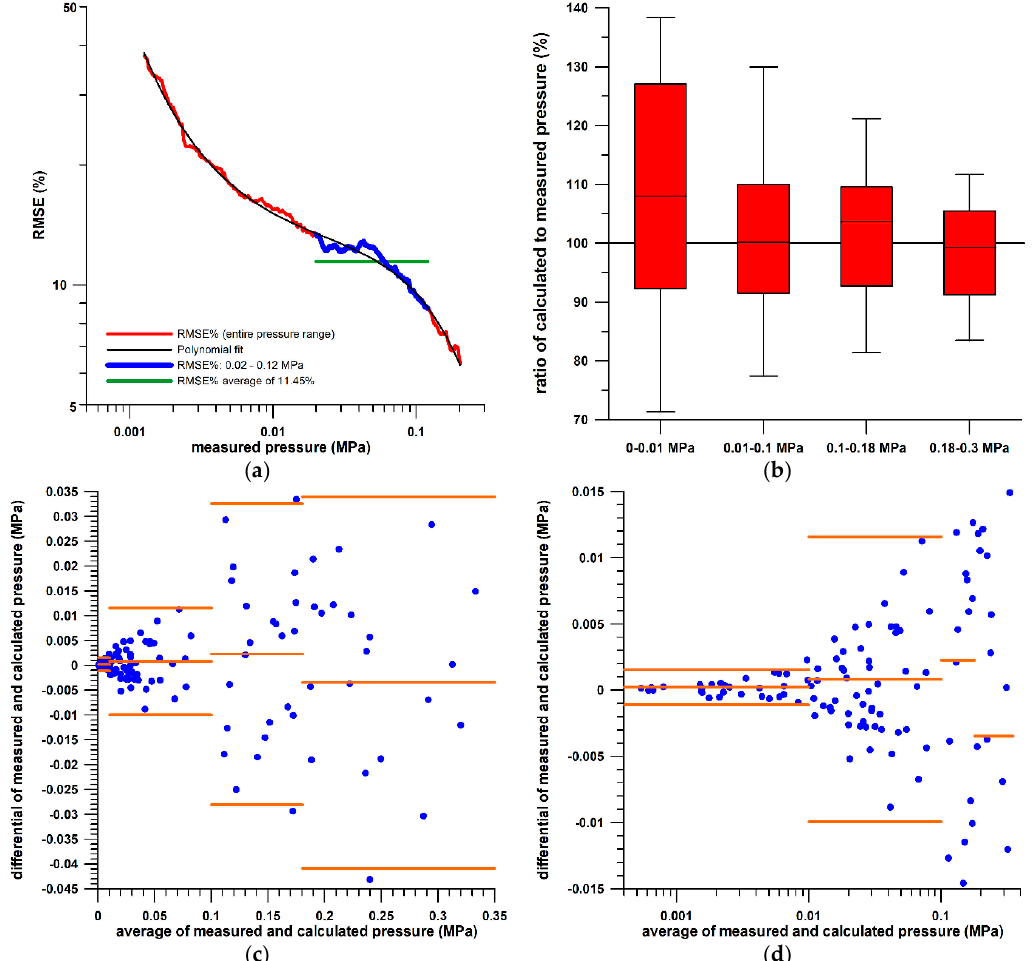
Figure 5. ( a ) Root mean square error (RMSE%) of the calculated pressure (as a percentage of the measured pressure) vs. the measured pressure; ( b ) box and whisker plot of the ratio of the calculated to the measured pressure (expressed as a percentage) for four different pressure ranges; ( c , d ): Bland–Altman plots of the pressure differential (measured pressure minus calculated pressure) vs. the average of measured and calculated pressures (linear and logarithmic scale); the orange horizontal lines indicate the average and the two limits of average ±1.96 standard deviations (95% confidence).